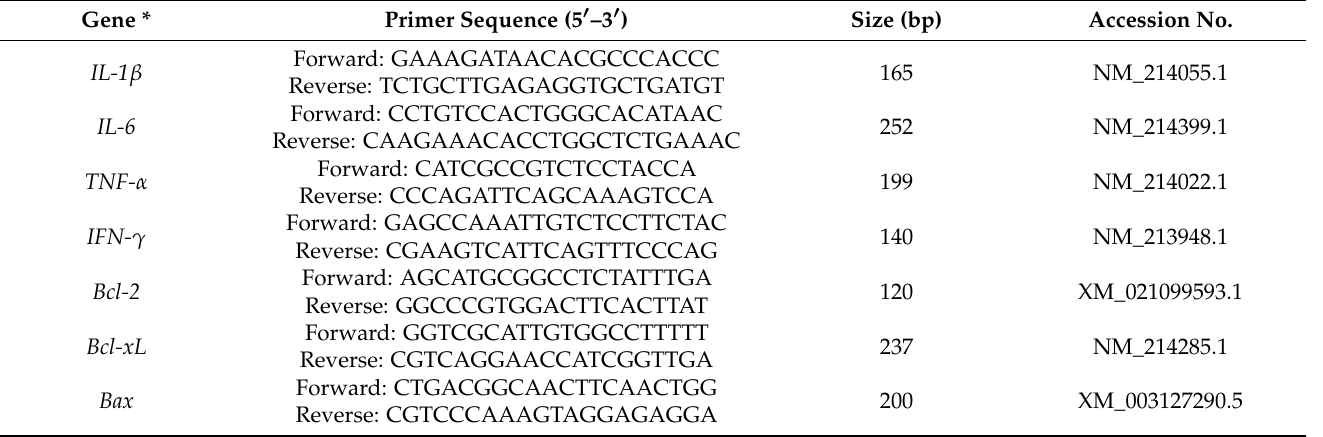
Table 1. Primer sequences for